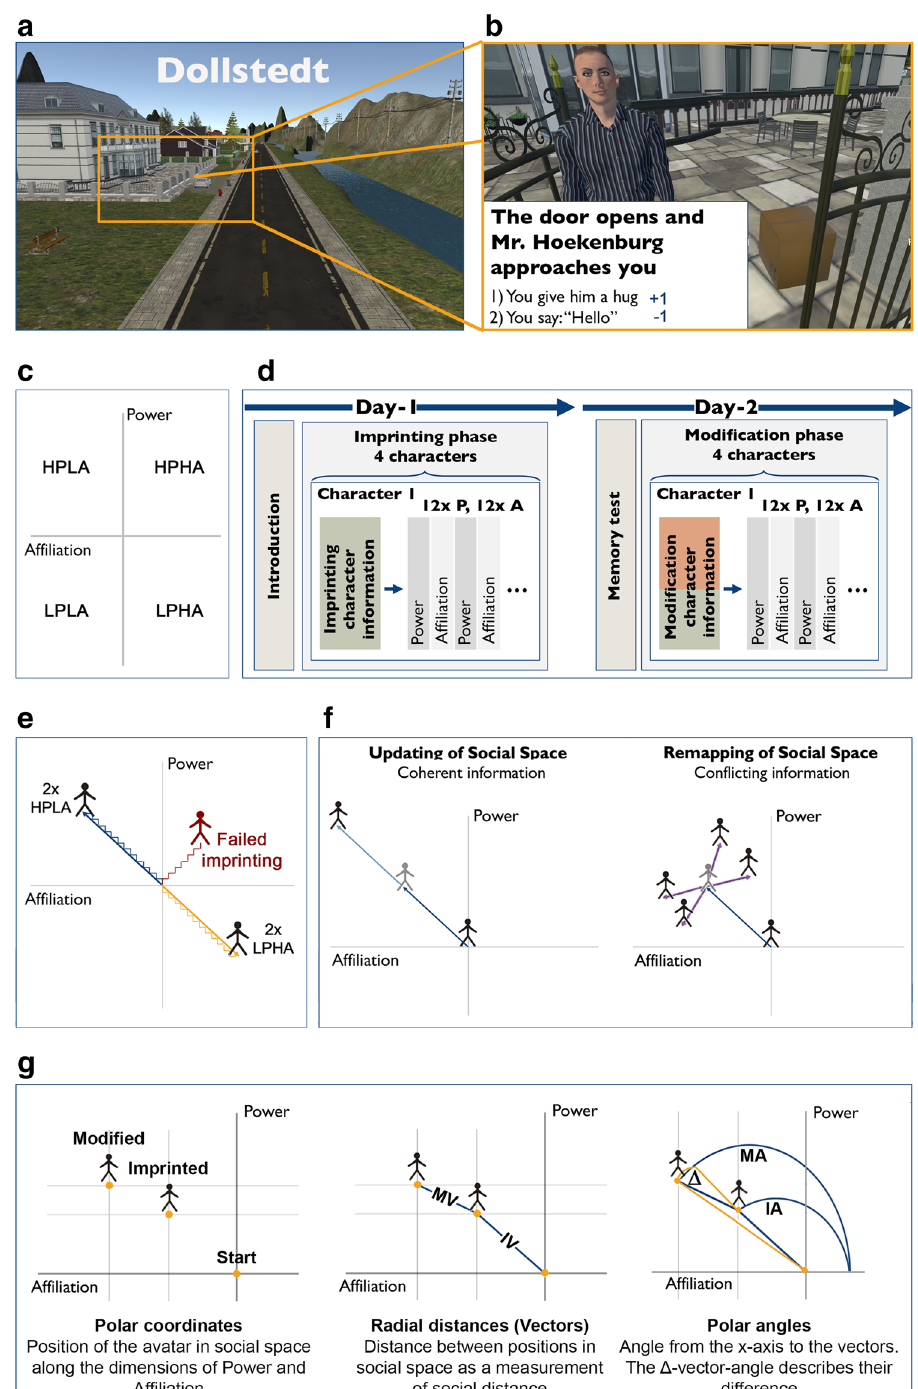
Figure 1. Paradigm and experimental design. ( a ) Scene from the fictional 3D-virtual reality (VR) city ‘Dollstedt’, where participants interacted with avatars. ( b ) Example interaction with an avatar: After a narrative (here: ‘You reach the house of Mr. Hoekenburg and ring the bell’), the participant was confronted with the decision of whether or not to hug Mr. Hoekenburg. Here, choosing 1) would add + 1 to the affiliation towards this avatar, choosing 2) would subtract − 1 of the affiliation towards this avatar. ( c ) Schematic overview of the 4 quadrants of ‘social space’ orthogonalized by the dimensions of power and affiliation. HPLA: high-power/low-affiliation, HPHA: high-power/high-affiliation, LPHA: low-power/high-affiliation, LPLA: low-power/low-affiliation. ( d ) Detailed timeline of the experiments of testing days 1 and 2. P: power, A: affiliation. ( e ) Imprinting-phase: n = 2 avatars were imprinted as HPLA (blue) and n = 2 as LPHA (orange). Participants with non-successful imprinting of at least one avatar were omitted (red). HPLA: high-power/low- affiliation, LPHA: low-power/high-affiliation. ( f ) Modification-phase: n = 1 HPLA- and n = 1 LPHA-avatar showed coherent behavior compared to the imprinting-phase (updating-avatars), whereas n = 1 HPLA- and n = 1 LPHA-avatar showed conflicting behavior compared to the imprinting-phase (remapping-avatars). Different possible scenarios of social remapping are displayed. ( g ) Overview of the dependent variables of interest: Polar coordinates, radial distances (vectors), and polar angles. MV: modification vector, IV: imprinting vector, MA: modification angle, IA: imprinting angle, Δ: delta